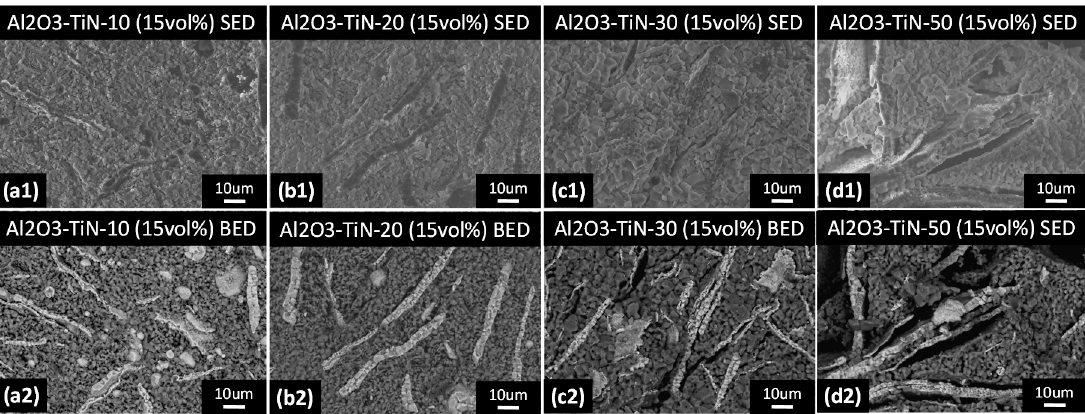
Figure 9. Comparison of the ( a ) maximum flexural stress and ( b ) porosity of the Al 2 O 3 –TiN-10, Al 2 O 3 – TiN-20, Al 2 O 3 –TiN-30 and Al 2 O 3 –TiN-50 composites with 5, 10, 15, and 20 vol % TiN addition, respectively.